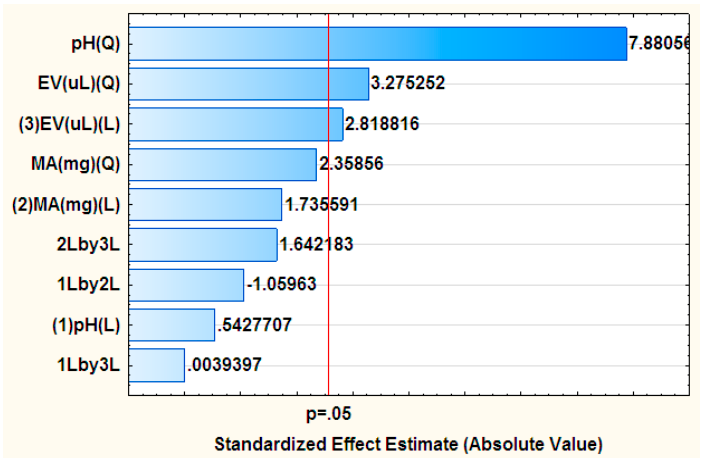
Figure 1. Pareto chart of standardized effects for variables in the preconcentration for parabens: The “Q” and “L” in brackets indicate whether the effects are quadratic or linear, respectively. The “2Lby3L” indicates the linear interactions between MA and EV, the “1Lby2L” referrers to the interactions between pH and MA and “1Lby3L” is for the the pH and EV